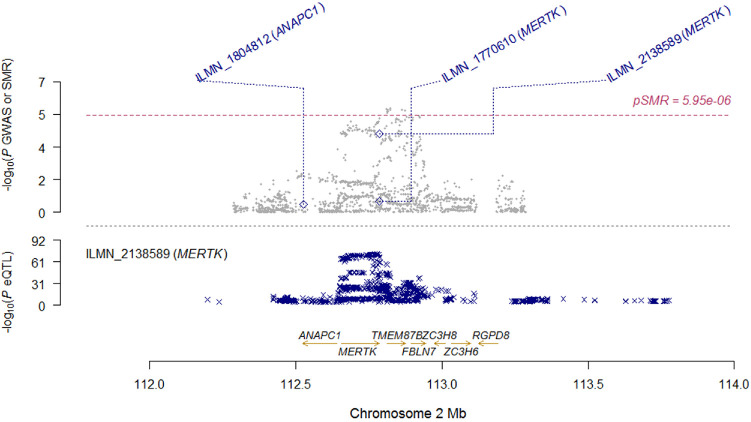
Locus zoom plot of SMR analysis for MERTK locus. Top plot, grey dots represent the P values for SNPs from the comparison between AS+AAU+ and AS+AAU-, diamonds represent the P values for probes from the SMR test. Bottom plot, the eQTL P values of SNPs from the CAGE study for the ILMN_2138589 probe tagging MERTK.